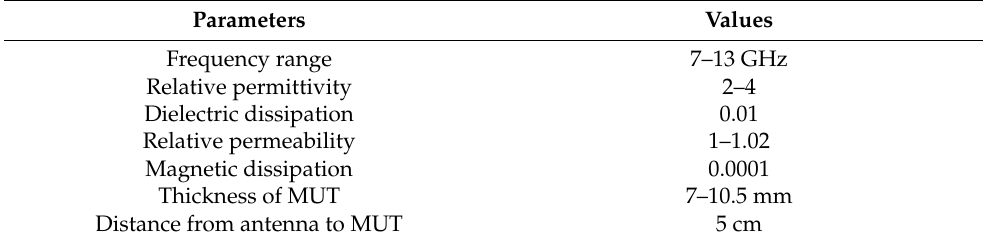
Table 1. Input parameters of simulation procedure.